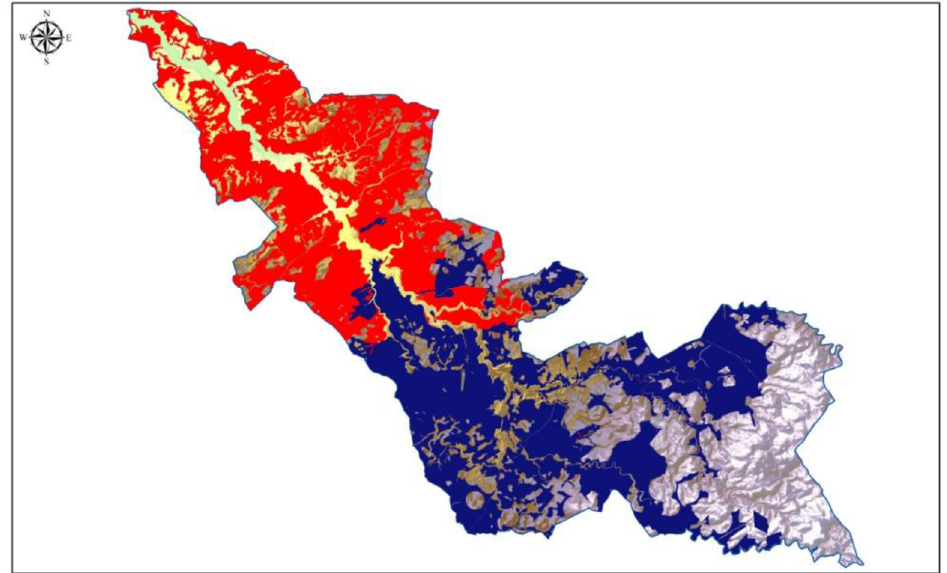
Figure 5. 9340 Quercus ilex L. and Quercus rotundifolia woods. Longitude 2°54′34″ W, latitude 38°57′34″ N (Lagunas de Ruidera). 834034 Asparago acutifolii-Quercetum rotundifoliae Rivas-Martínez, Cantó, Fernández-González, and Sánchez Mata in Rivas-Martínez et al. 2002. (Lagunas de Ruidera, red polygons). 834033 Junipero thuriferae-Quercetum rotundifoliae Rivas-Martínez 1987. (Lagunas de Ruidera, blue polygons). Included are the maps made in the different SCIs, silicicolous, and basophilous holm oak forests in both the mesomediterranean and the supramediterranean, with these latter acting as a transition to the juniper forests of Juniperus thurifera L.